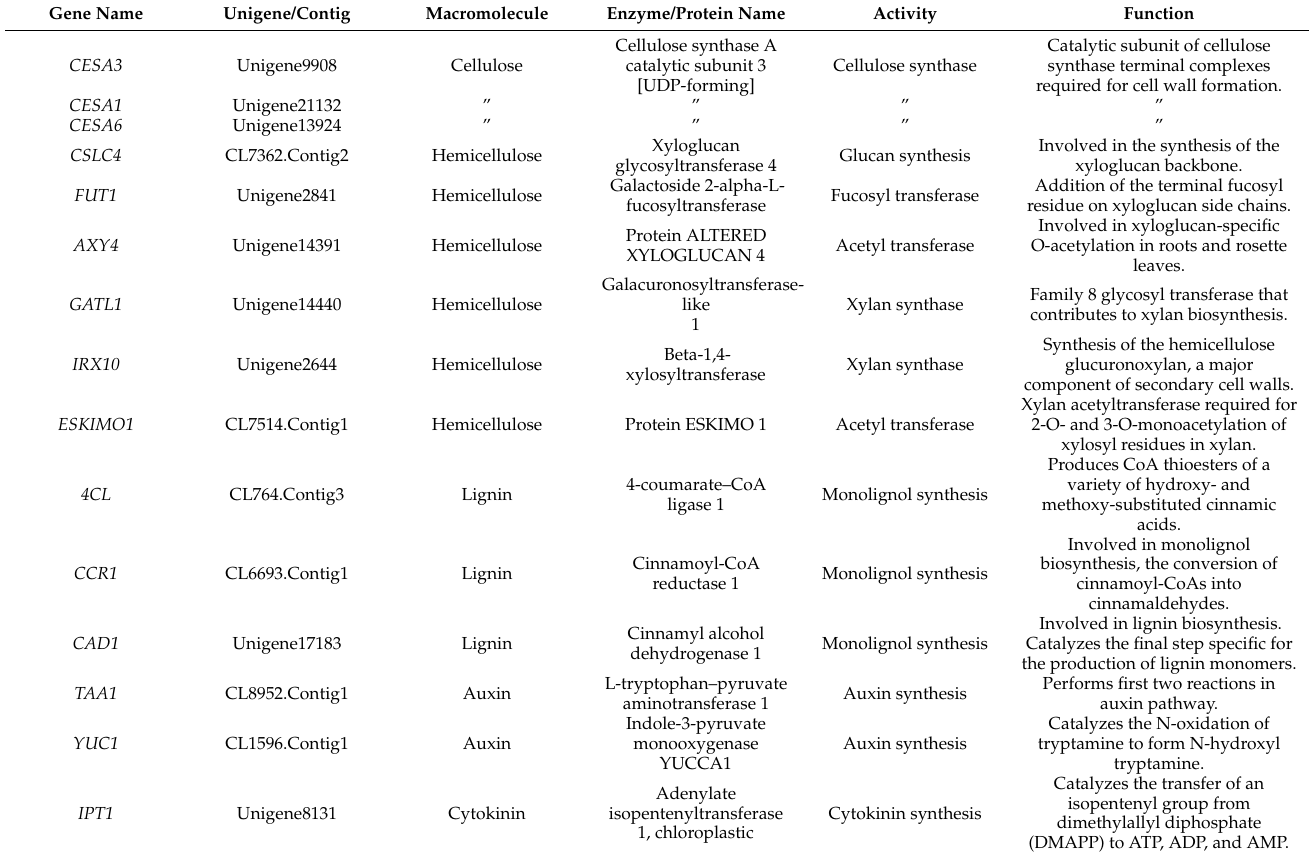
Table 5. Wood-Forming Genes Selected for RT-qPCR Expression